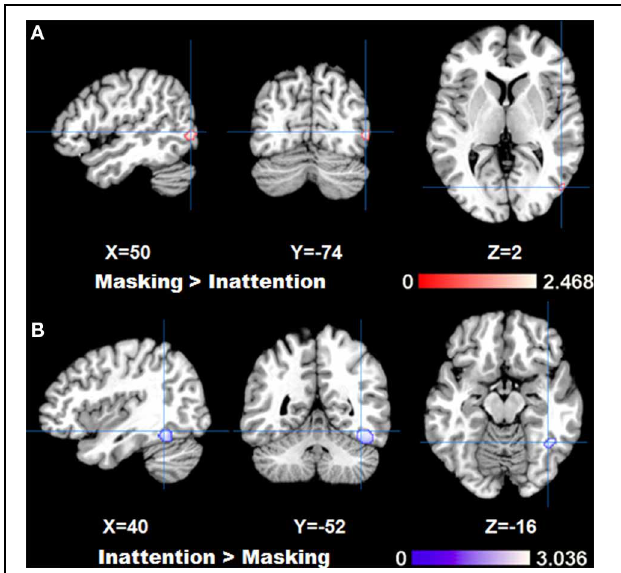
FIGURE 2 | Results of ALE analysis for comparison between tasks, (A) masking > inattention task; (B) inattention > masking task showing areas with maximal z -values ( p < 0 . 05; FDR corrected; k >